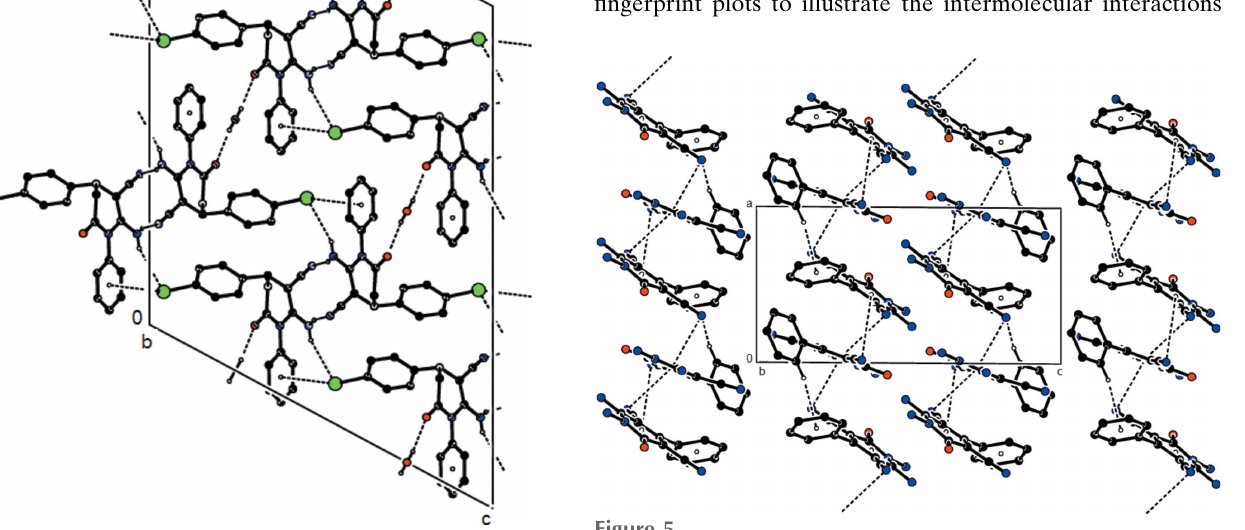
Figure 4 Crystal packing of compound (I) viewed down the b axis, showing the O—H (cid:2)(cid:2)(cid:2) O, N—H (cid:2)(cid:2)(cid:2) O and C—Br (cid:2)(cid:2)(cid:2) (cid:2) interactions.